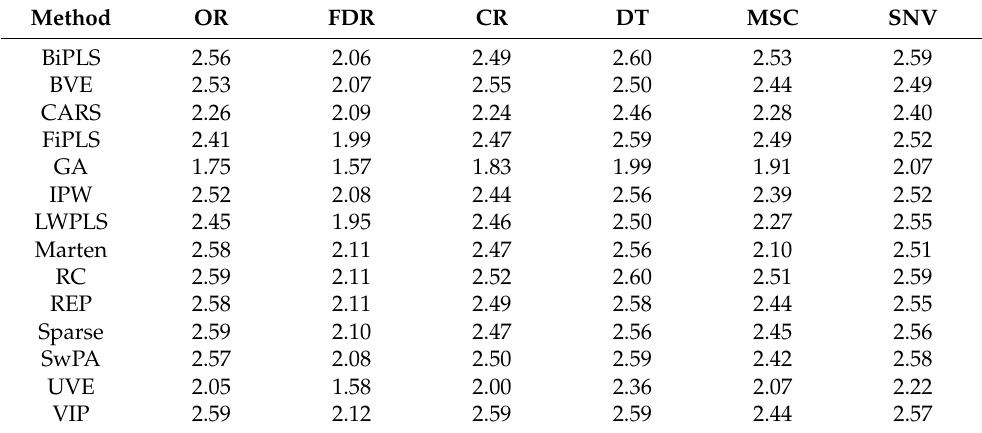
Table 3. Ratio of performance to deviation (RPD) for each regression model (100 repetitions).